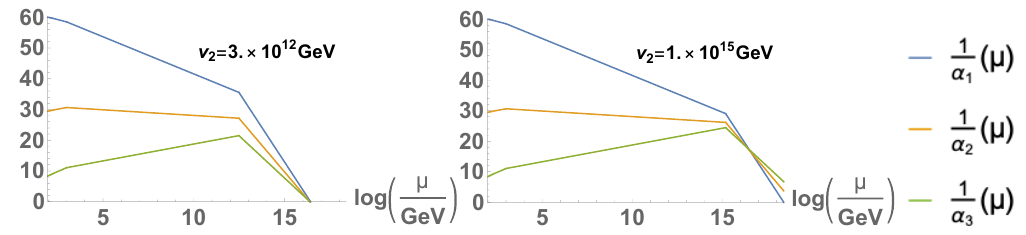
Figure 3 . Running coupling constants of the MSSM in model B, assuming m soft =